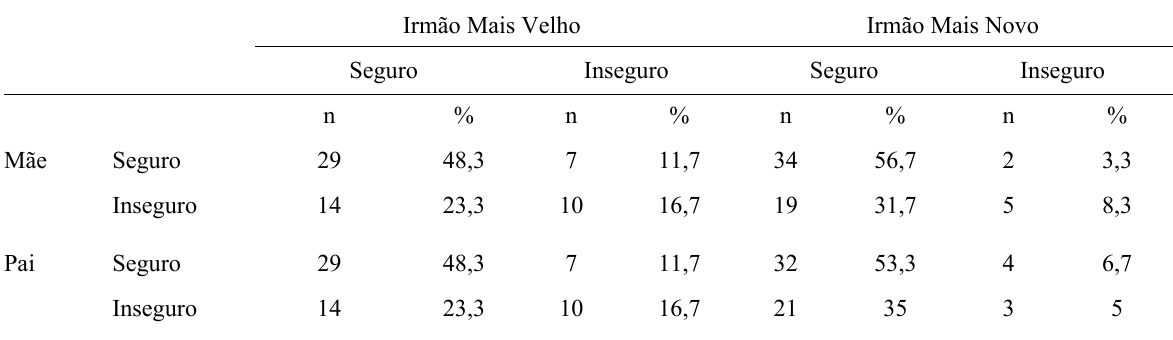
Frequência e Percentagens das Associações entre Segurança/Insegurança de Pais e